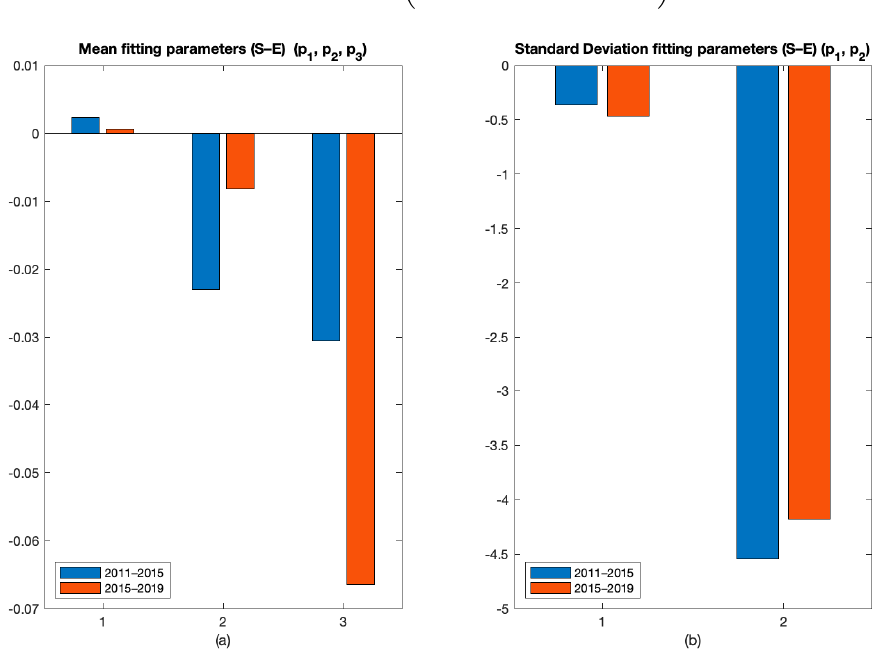
Figure 15. Fitting parameters of the energy-velocity dispersions in the two periods for a building complex near San Giovanni station: ( a ) parameters of the mean model; ( b ) parameters of the standard deviation model.